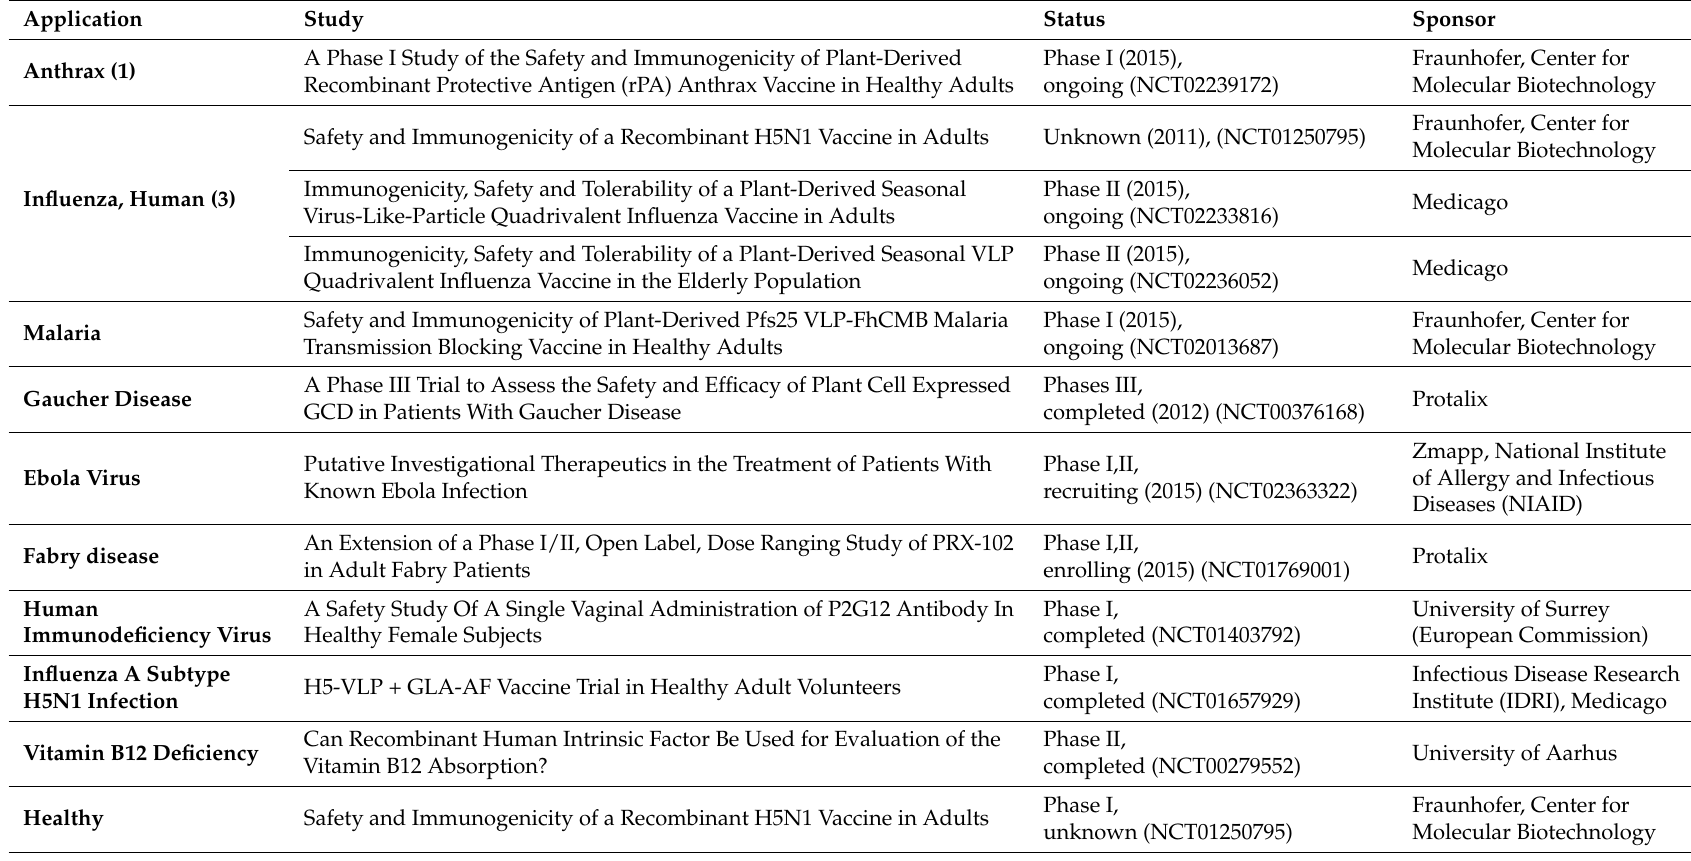
Table 1. Clinical studies of plant-derived vaccines (data from US National Institutes of Health clinical